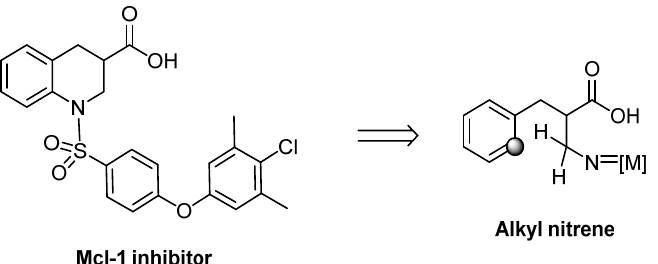
Figure 4. Retrosynthetic analysis proposed for the formation of myeloid cell leukemia-1 (Mcl-1) inhibitor.